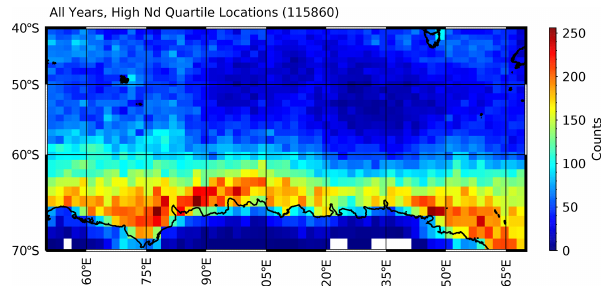
Figure 3. Geographic distribution of the high- N d -quartile cloud scenes. The number in parentheses shows the total of number cloud scenes from the 5-year summer data set.